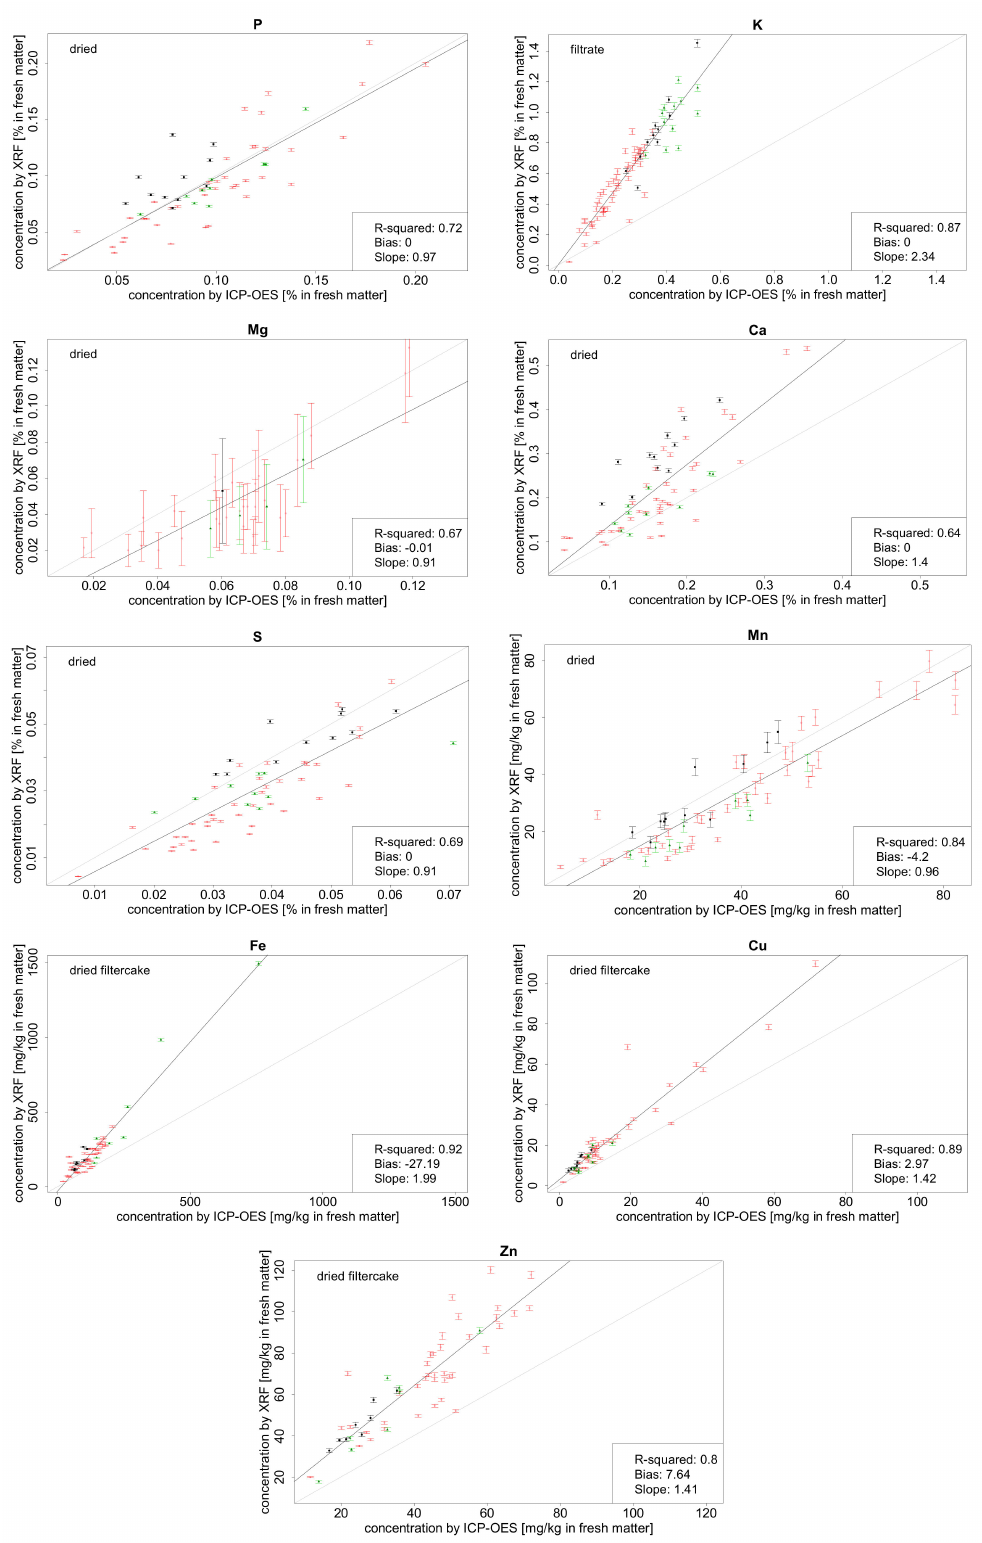
Figure 3. Best relationships between XRF and standard lab procedure based concentrations of P, K, Mg, Ca, S, Mn, Fe, Cu and Zn showing R 2 , bias, slope, XRF standard derivations, regression line (black), and 1:1 line (grey). For K, XRF concentrations are shown for filtrate samples, for Fe, Cu and Zn for dried filter residues and for P, Mg, Ca, S, and Mn for dried samples (red = pig, black = cattle, and green = digestate